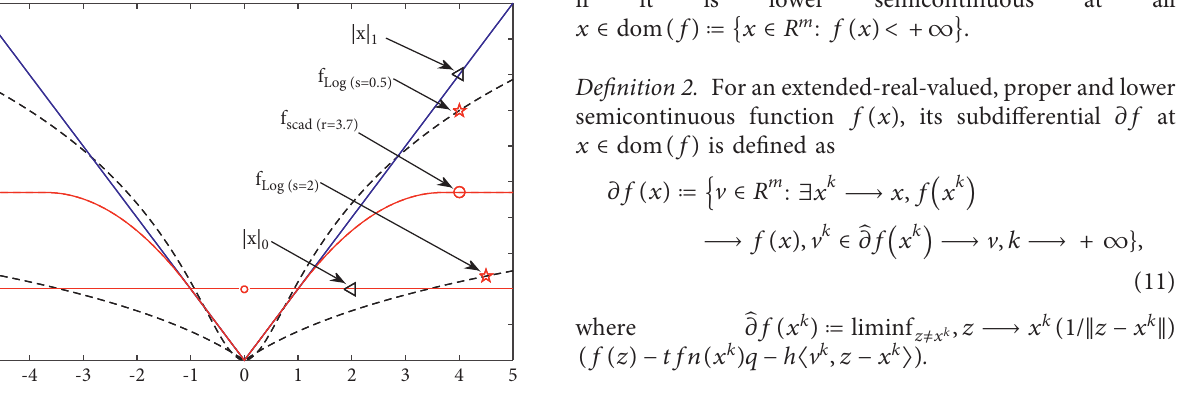
Figure 1: Plot of | x | f log